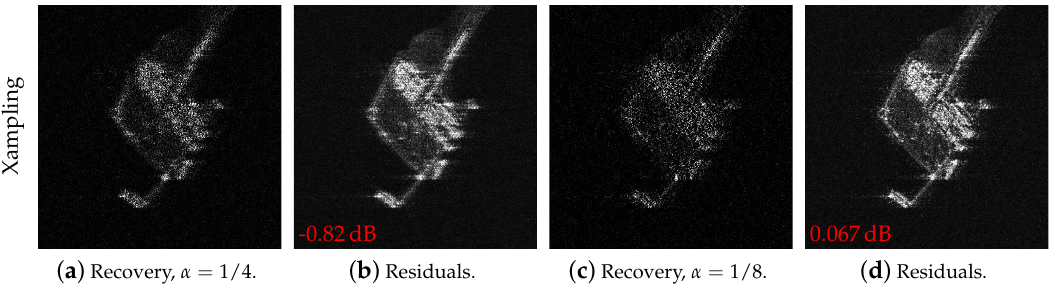
Figure 8. Recovery of the RADARSAR-1 image. From top to bottom: QuadCS-IndSeq, QuadCS-EquSeq, Xampling. From left to right: recovered images and corresponding residuals with compression ratios 1/4 and 1/8. Range and azimuth are along the horizontal and vertical axes, respectively. The relative errors for these images are shown at the lower left corners of their residual images, respectively. Due to lack of scene sparsity, all of the simulated systems cannot provide satisfactory